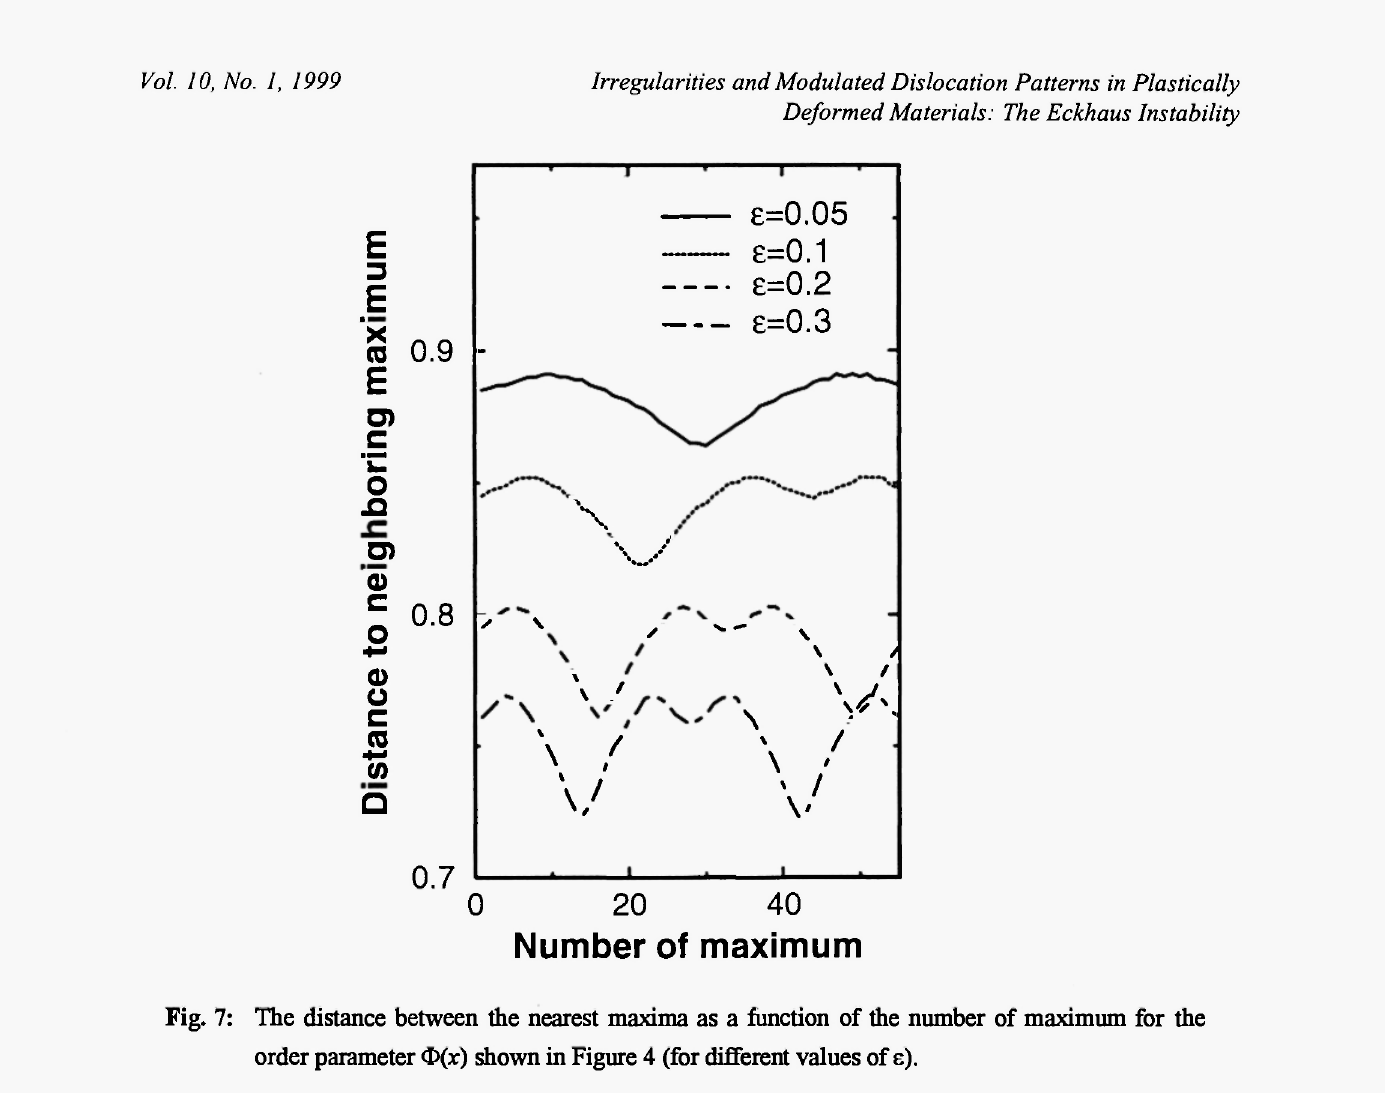
Fig. 7: The distance between the nearest maxima as a function of the number of maximum for the order parameter Φ(χ) shown in Figure 4 (for different values of